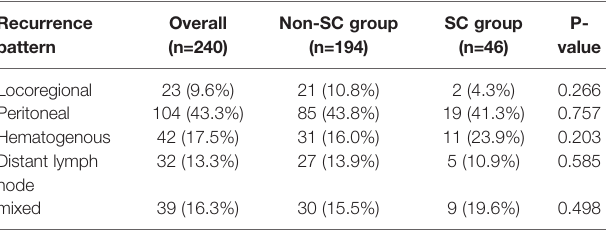
TABLE 6 | Comparison of initial recurrence site according to serious complications in patients with